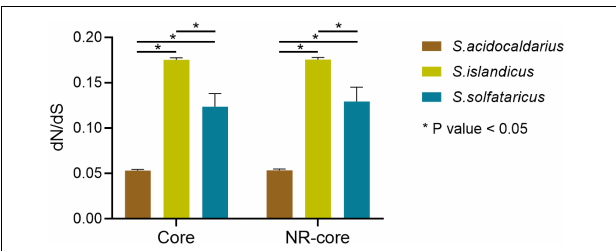
FIGURE 3 | Average dN/dS values for the core genes and non-recombinant core genes belonging to the species with multiple strains ( S. islandicus , S. solfataricus , and S. acidocaldarius